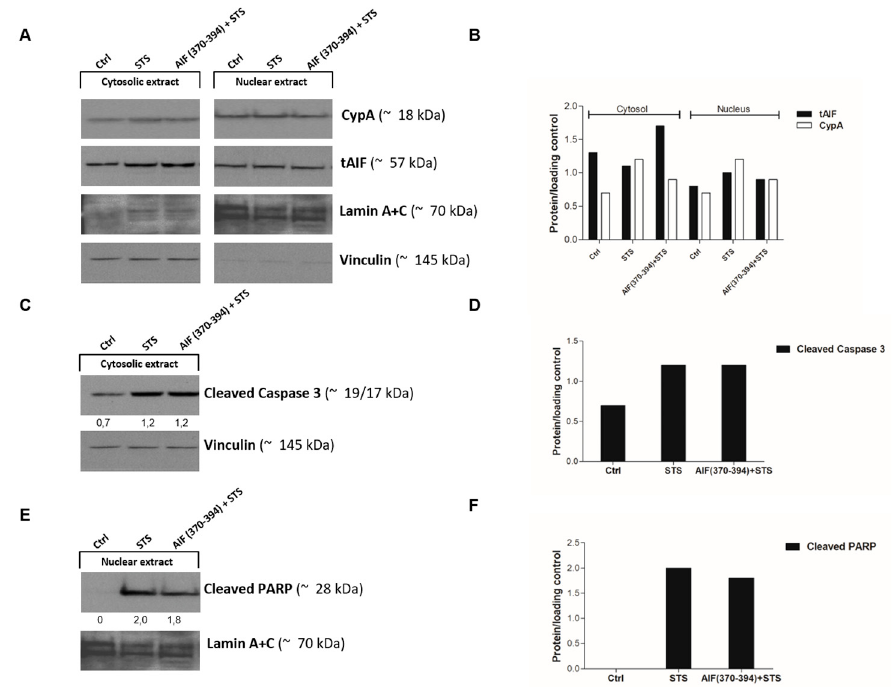
Figure 4. AIF(370-394) blocks AIF and CypA nuclear translocation induced by STS. ( A ) Representative immunoblots of CypA and tAIF and relative densitometric bar graph of proteins ( B ) in the cytosolic and nuclear fractions of SH-SY5Y cells untreated or treated with 5 µ M STS for 3 h. ( C ) Representative immunoblot for the detection in the cytosolic extract of cleaved caspase 3 and ( D ) cleaved PARP in the nuclear extract and relative densitometric bar graphs of proteins ( E ). Densitometric analyses were performed using vinculin and lamin A/C as markers of cytosolic and nuclear proteins, respectively.